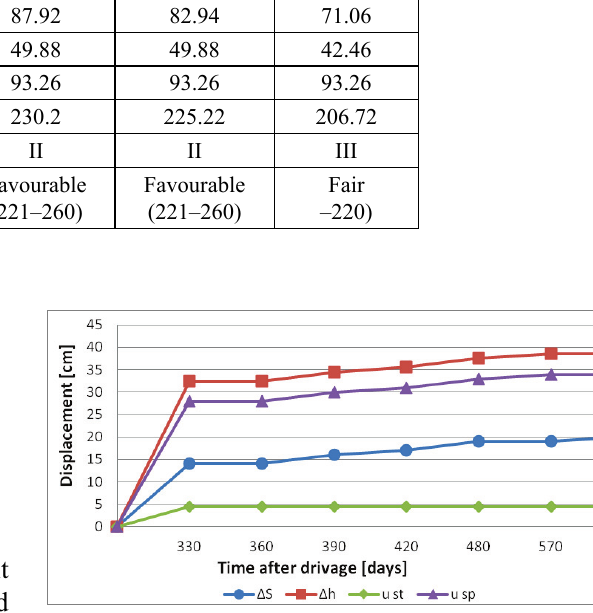
Fig. 3. Maingate D-2 convergence – base on 930 m (  S – roadway width change,  h – roadway height change, u st – roof displacement, u sp –floor heaving)